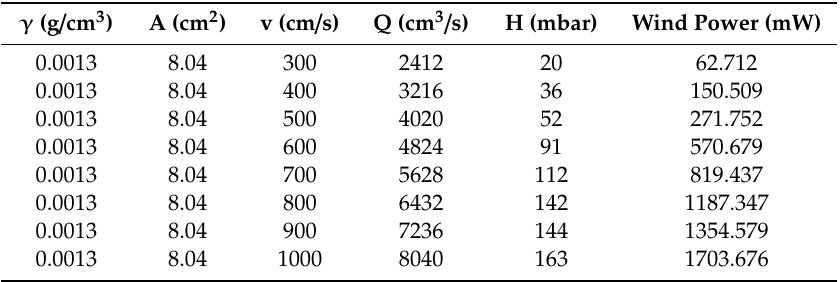
Table 9. Measured wind power values for di ff erent wind flow